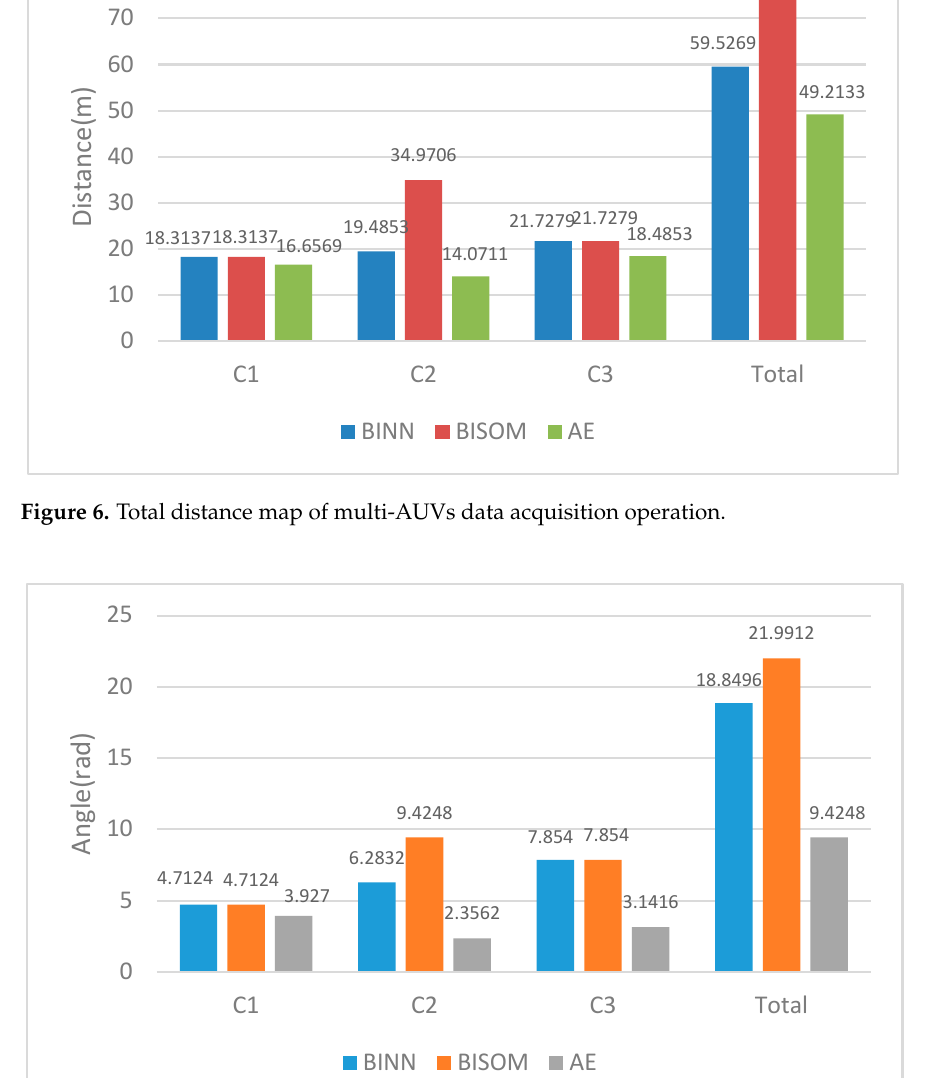
Figure 6. Total distance map of multi-AUVs data acquisition operation.